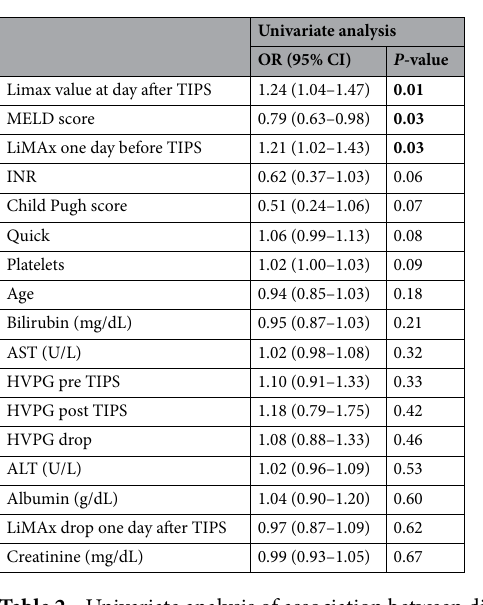
Table 2. Univariate analysis of association between different possible prognostic parameters and transplant- free survival after TIPS. Bold values indicate statistically significant at P < 0.05. ALT alanine aminotransferase, AST aspartate aminotransferase, HVPG hepatic venous pressure gradient, INR international normalized ratio, MELD model for end-stage liver disease, TIPS transjugular intrahepatic portosystemic shunt.